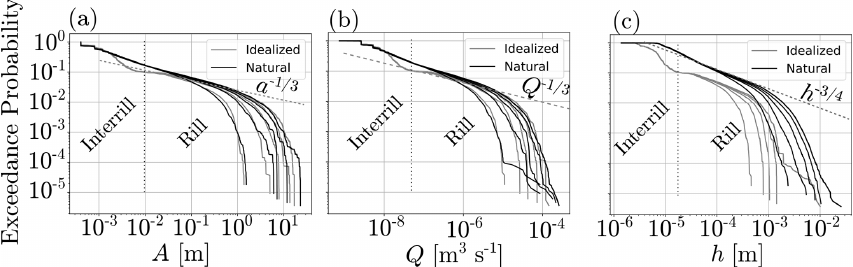
Figure 14. Exceedance probability plots for (a) contributing area, (b) discharge, and (c) flow depth from the hillslope in northern Arizona and an idealized slope. Log–log slopes from theory are plotted on top of the data. The log–log slope in (c) is for p = 1 / 3 in r w = kQ p